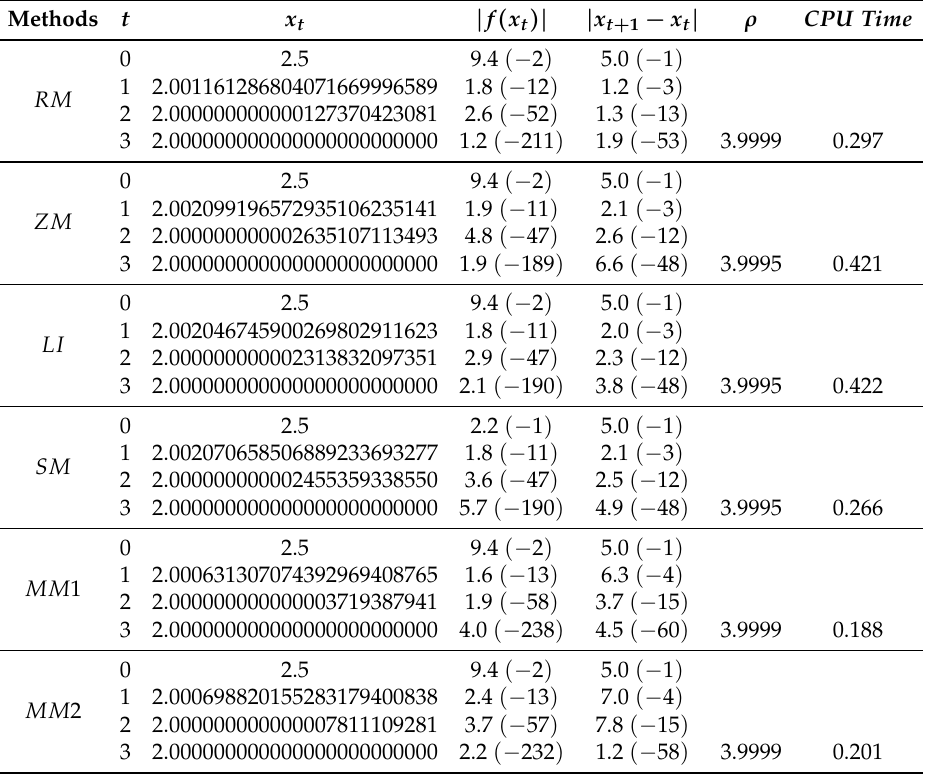
Table 5. Outcomes for comparison by testing schemes on Example